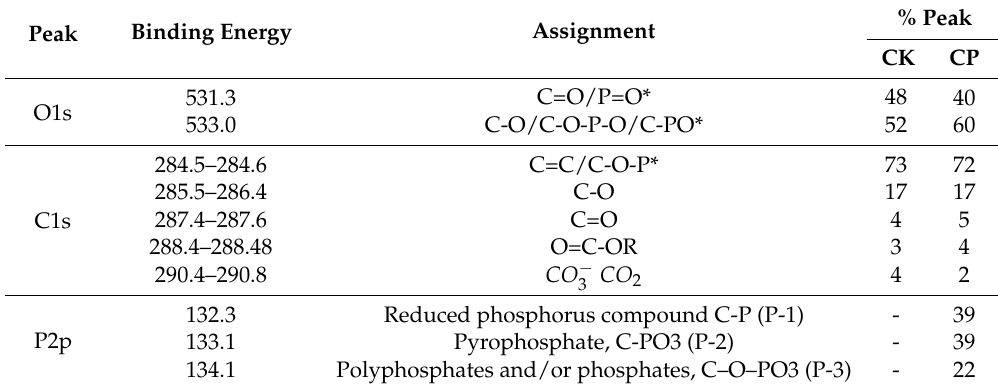
Table 2. Chemical bonds of activated carbons prepared by chemical activation of olive stones with potassium hydroxide (CK) and phosphoric acid (CP); estimated by deconvolution of XPS signals.